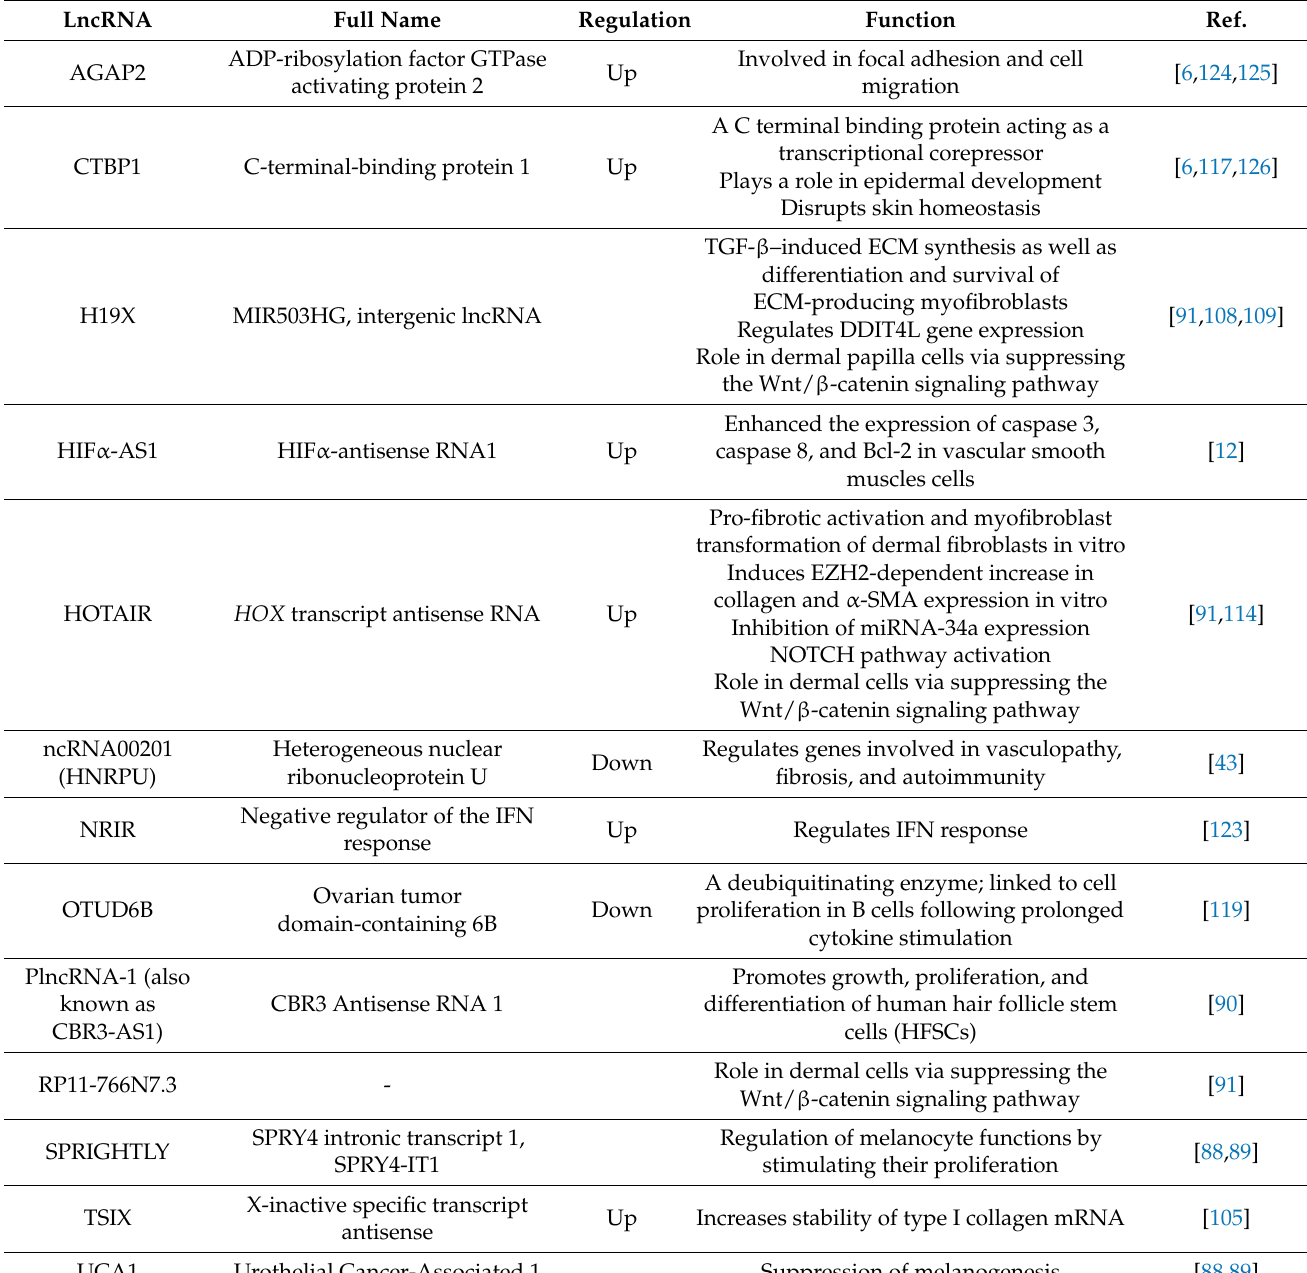
Table 1. Selected lncRNAs and their pathogenic role in SSc